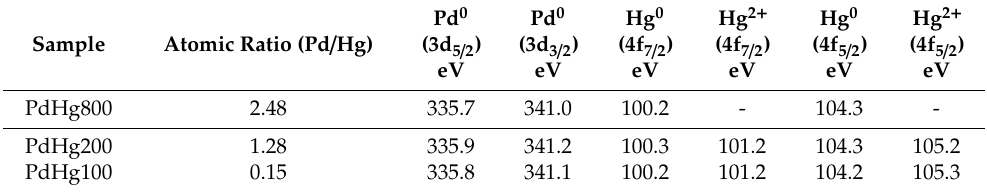
Figure 8. CV analysis in CO 2 saturated 0.1 M KHCO 3 solution at the scan rate of 50 mV · s − 1 for PdHg800, PdHg200, PdHg100 and Pd. Table 2. Atomic ratio of Pd/Hg and binding energy (B.E.) of Pd and Hg with Pd amalgams prepared with the different Hg/Pd atomic ratios .